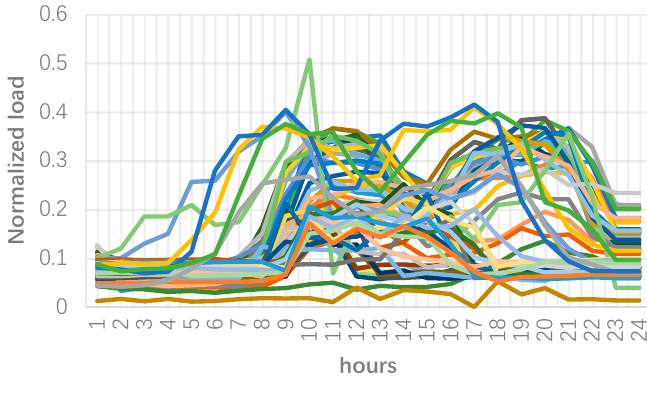
Figure 6. Load curves of consumers in cluster 1.